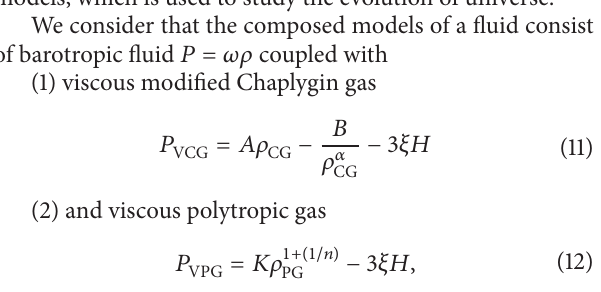
pictures in the dynamics of homogeneous cosmological models, which is used to study the evolution of